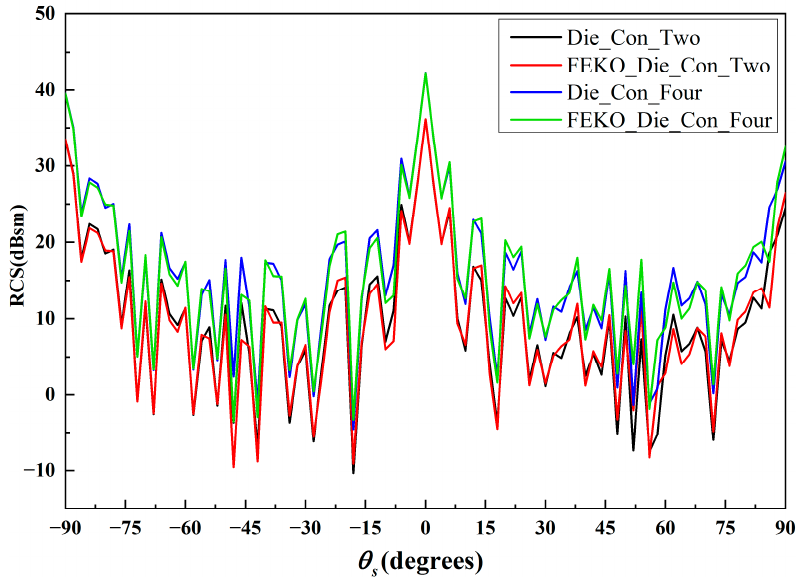
Figure 6. Mono-static RCS for HH polarization of different numbers of hybrid dielectric and conductor cubes in free space.